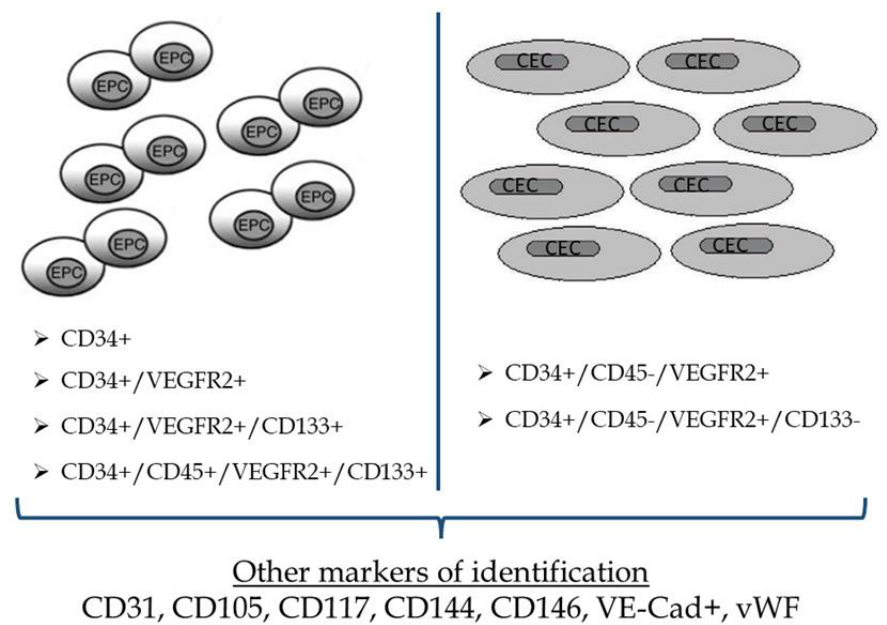
Figure 2. Most common markers used for the identification of Endothelial Progenitor cells and Circulating Endothelial cells. EPCs, endothelial progenitor cells; CECs, circulating endothelial cells; VEGFR, vascular endothelial growth factor receptor.